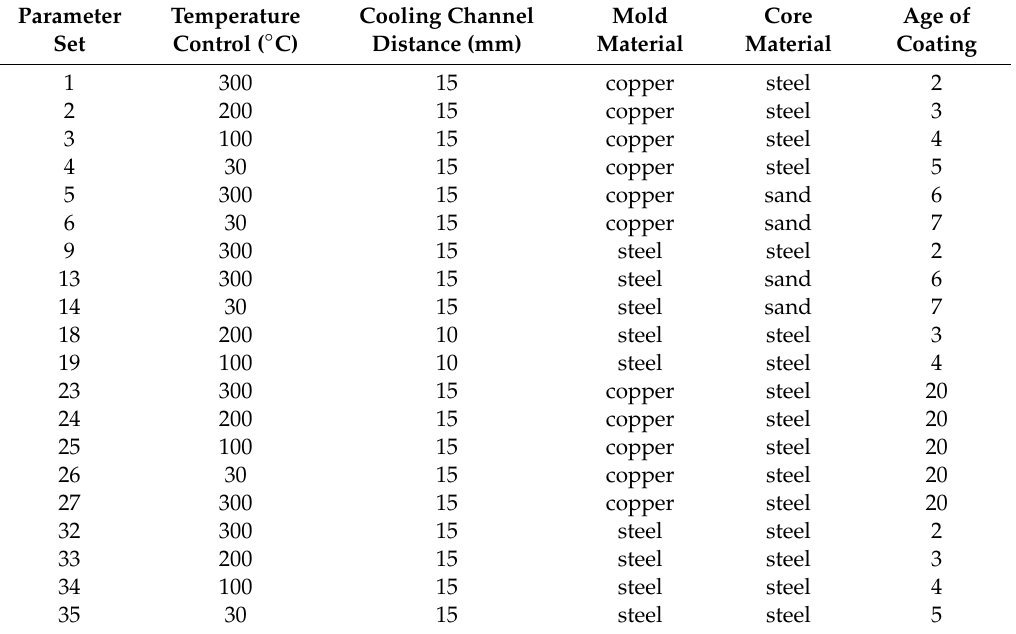
Figure 3. Measurements of temperatures, gap formation, and contact pressure building for the experiment with copper die inserts, steel core, and the temperature control set to 100 ◦ C [13]. Table 3. Parameter sets used for the statistical analysis.